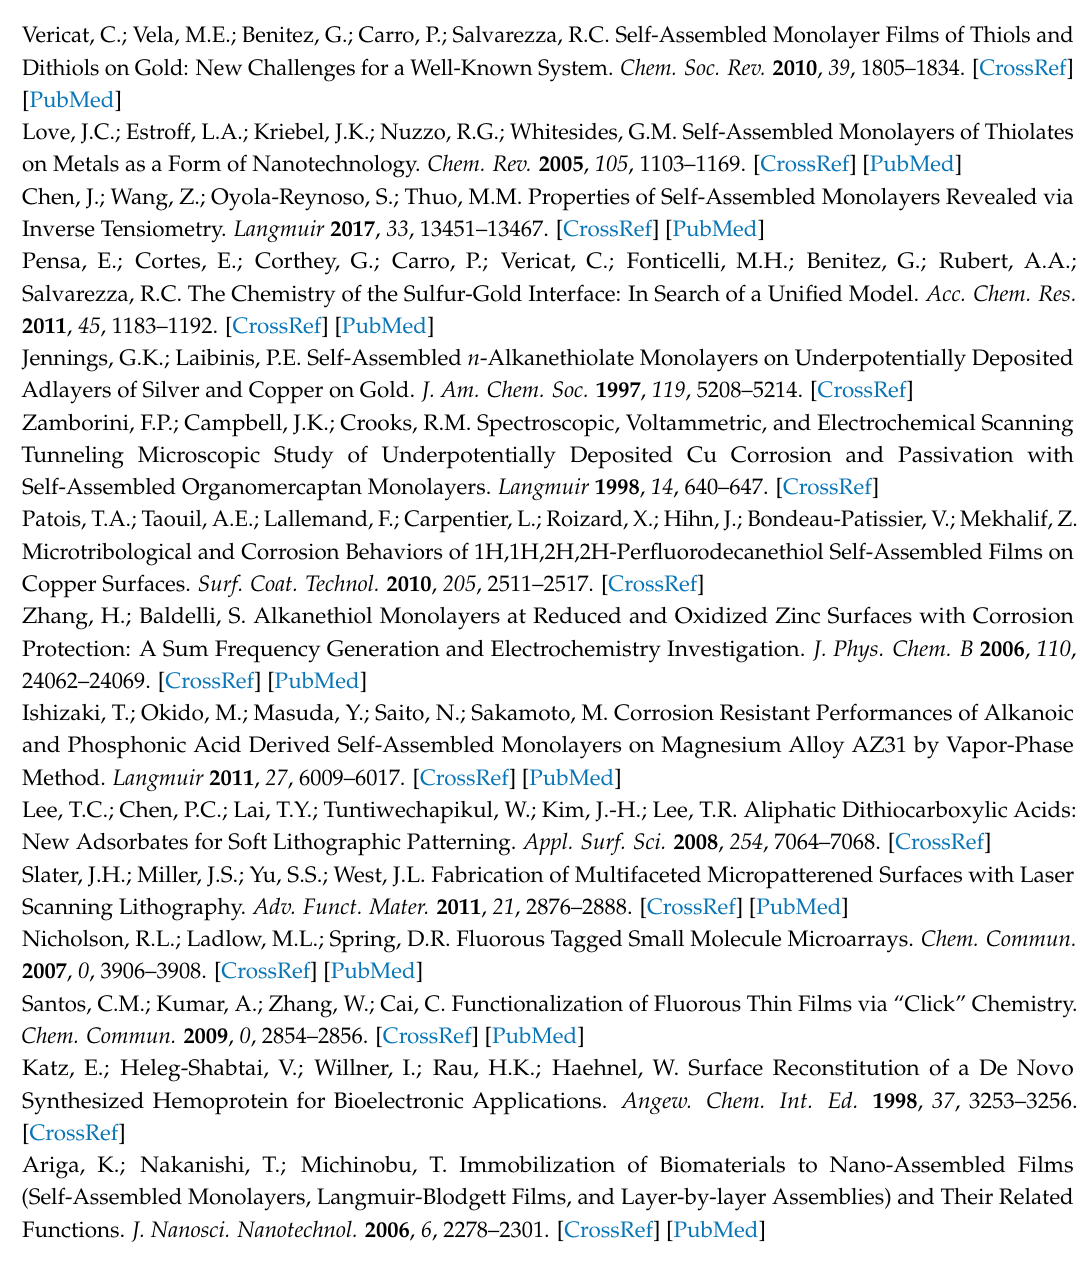
Table S2: Calculated Surface Energy Values of the